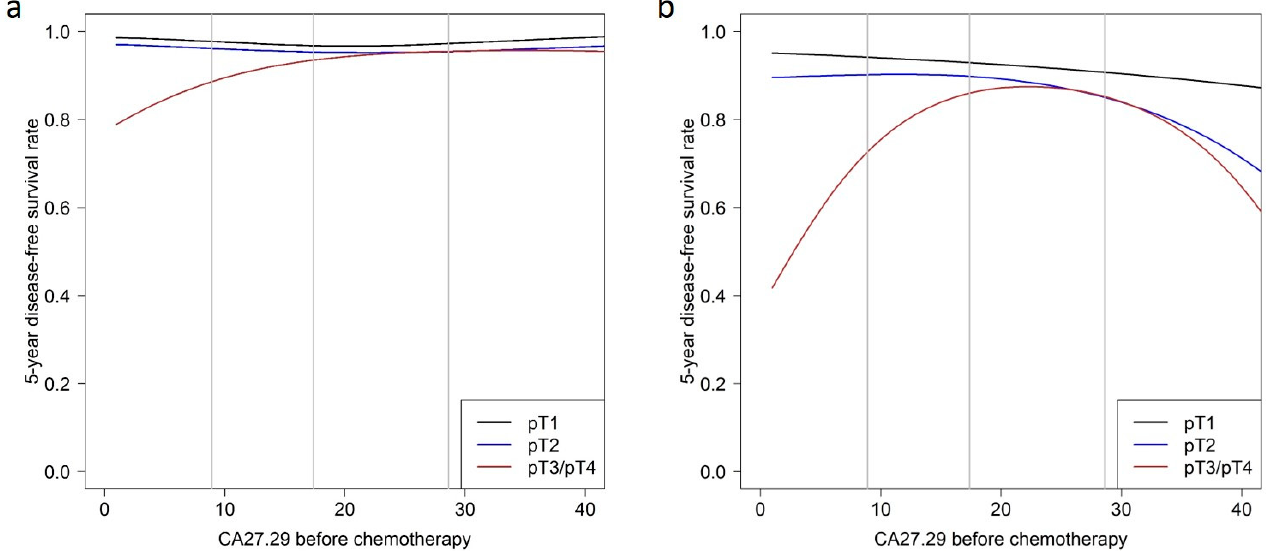
Figure 2. The 5-year disease-free survival rate as a function of CA27.29 before chemotherapy relative to tumor size for ( a ) patients with negative lymph-node status and ( b ) patients with positive lymph- node status. Vertical gray lines indicate the 25th, 50th, and 75th percentiles for CA27.29 before chem- otherapy.